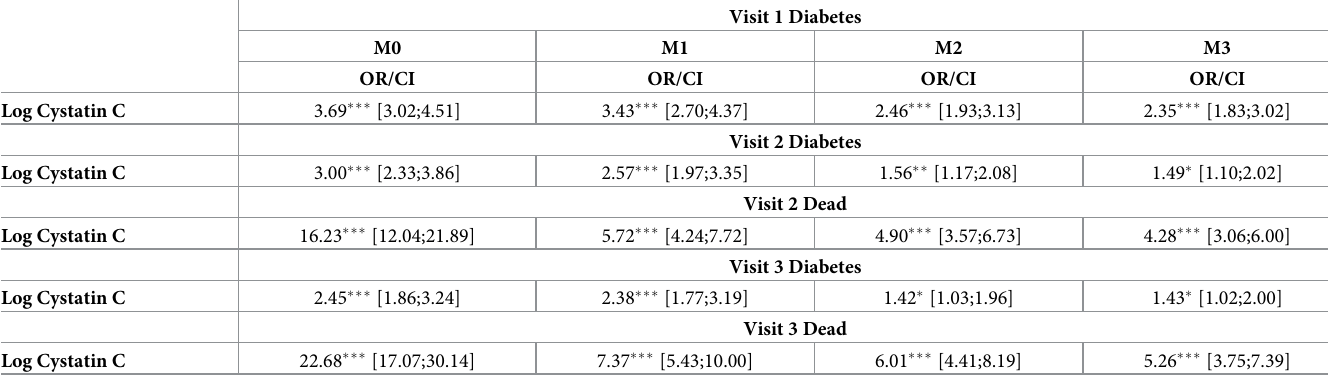
S1 File. Compared to men, women were older and less likely to report having education beyond high school ( > 12 years). Women had higher cholesterol and CRP levels, but lower rates of mortality and diabetes compared to men at all time points. Differences in log Cystatin-C based on diabetes or death status are presented in S1 Table in S1 File. Log Cystatin-C values at visit 3 were higher for every group compared to visit 1, and trends were consistent for all visits: those without diabetes had the lowest Cystatin-C levels, fol- lowed by those with diabetes and those that died over the observation period. Lastly, we per- formed cross tabulations across the visits to test for spread among the groups. Those with diabetes at visit 1, while only consisting of 21% of the cohort, represented more than 30% of the dead at visit 2 and visit 3 (S2 Table in S1 File). Results from the multinomial logit models can be found in Table 2, Fig 1, and S3 Table in S1 File. Higher log Cystatin-C values were associated with increased odds of diabetes and mor- tality at each time point. The following formula: 10 � log(Odds Ratio) was used to convert odds ratios of log Cystatin-C to percentage risk increase in outcome based on 10% increase in Cysta- tin-C values (i.e. based on the original metric). A 10% increase in Cystatin-C, measured at visit 1, was associated with 13% increase in the odds ratios of diabetes (log Cystatin-C OR Table 2. Association between log cystatin-C and diabetes and death status at visit 1, visit 2, and visit